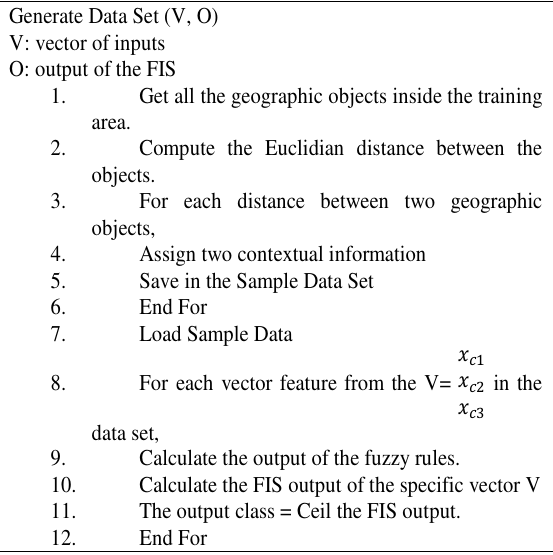
Table 4: NFC data set training preparation